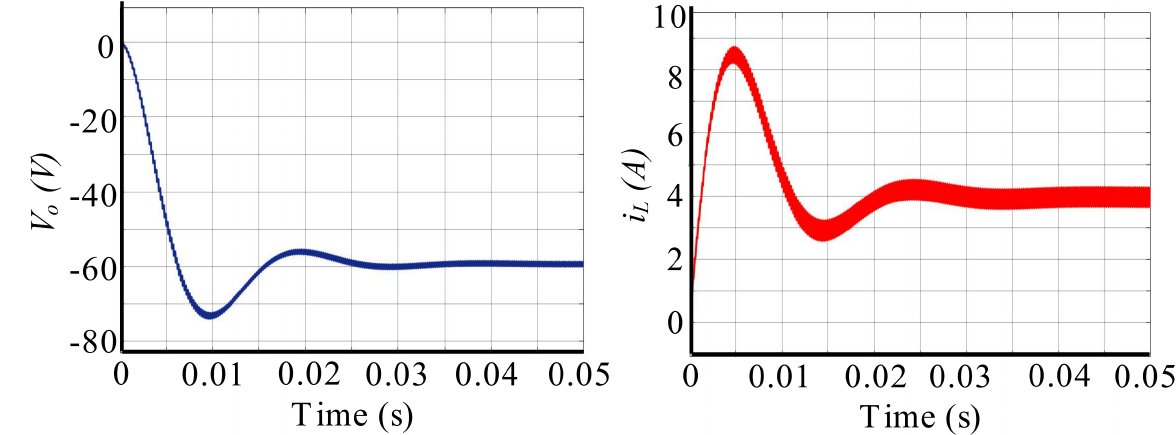
Figure 10. Graph of the S 2 parameter set ICCV in continuous time through (20)–(23) and knowledge of the ICCV at the beginning of each switching